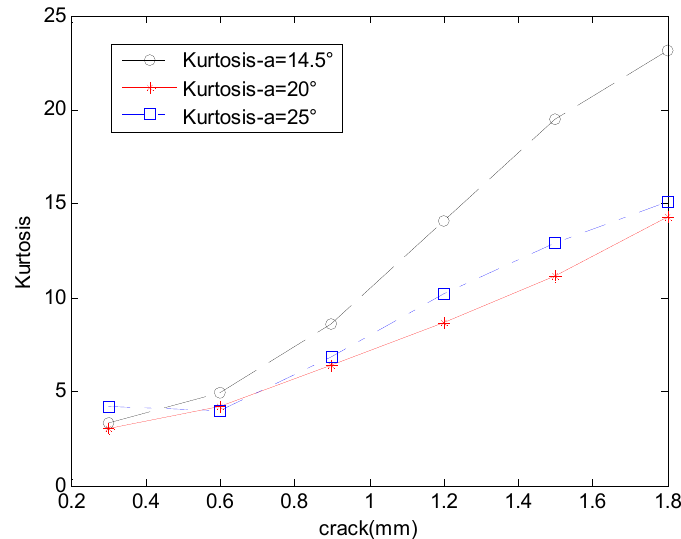
ff erent pressure angles.